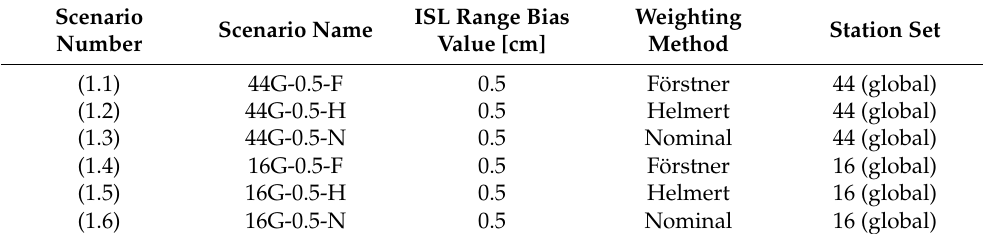
Table 3. Summary of the simulation scenarios used for comparison of the VCE approaches.